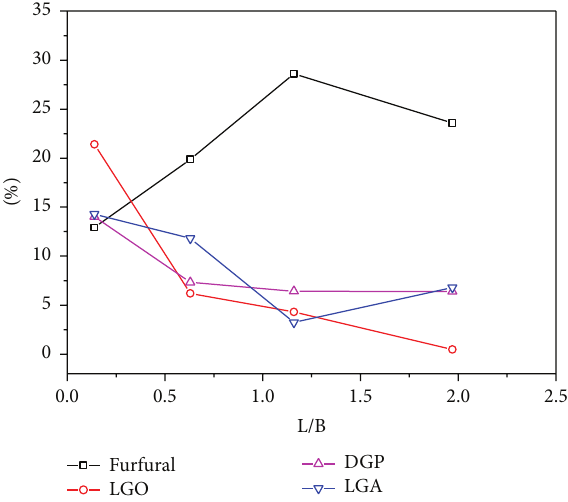
Figure 7: Effect of the L/B ratio of Zn/ZSM-5 on the percentage of ( ◻ ) furfural, ( I ) LGO, ( △ ) DGP, and ( 󳶚 ) LGA of the biooil derived from the catalytic pyrolysis of cellulose at 400 ∘ C.